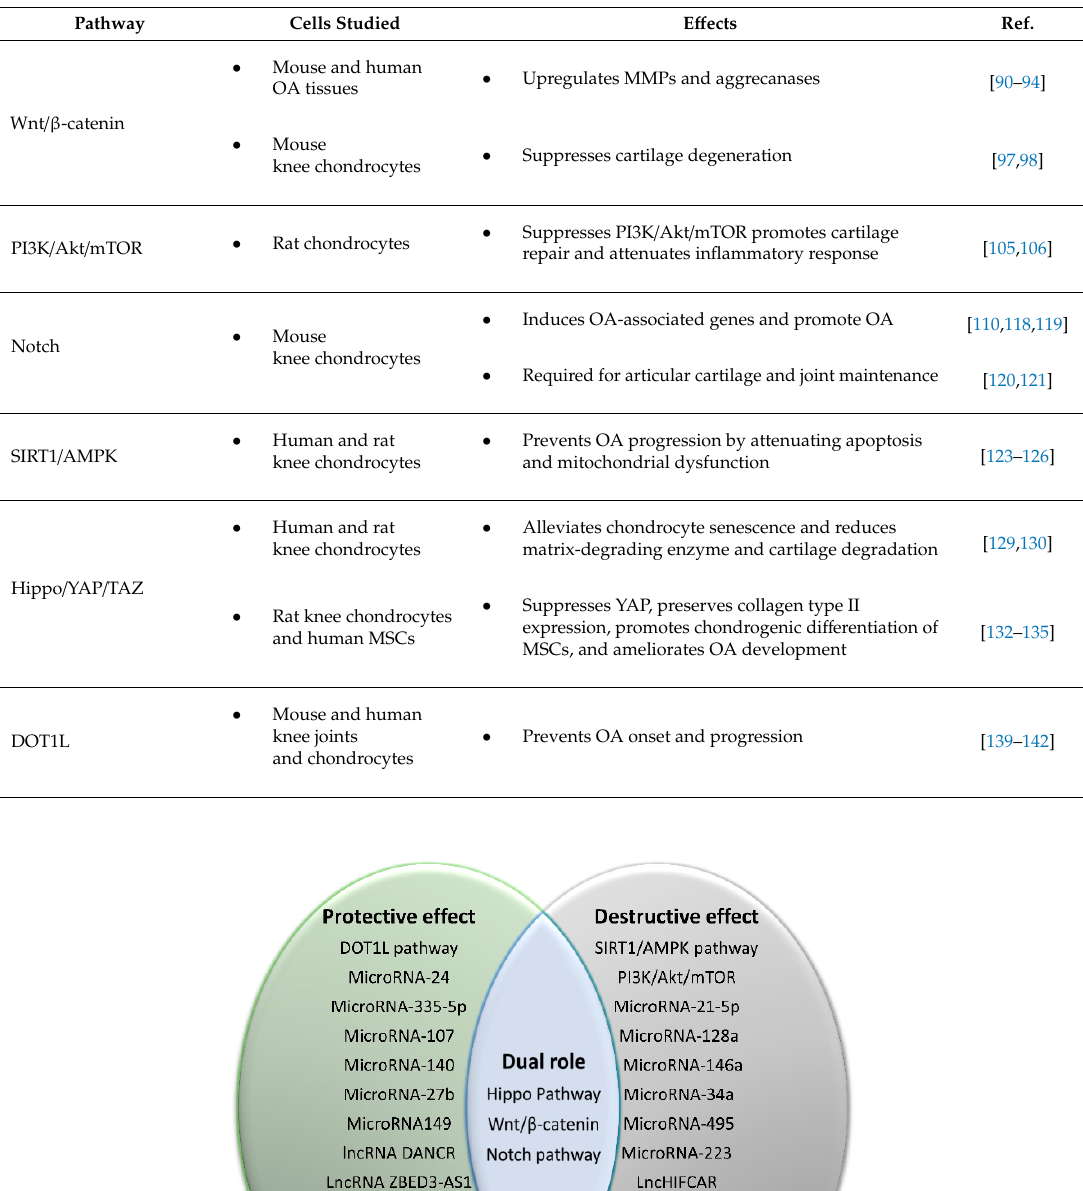
Table 1. Regulatory pathways mediating chondrocyte functions.